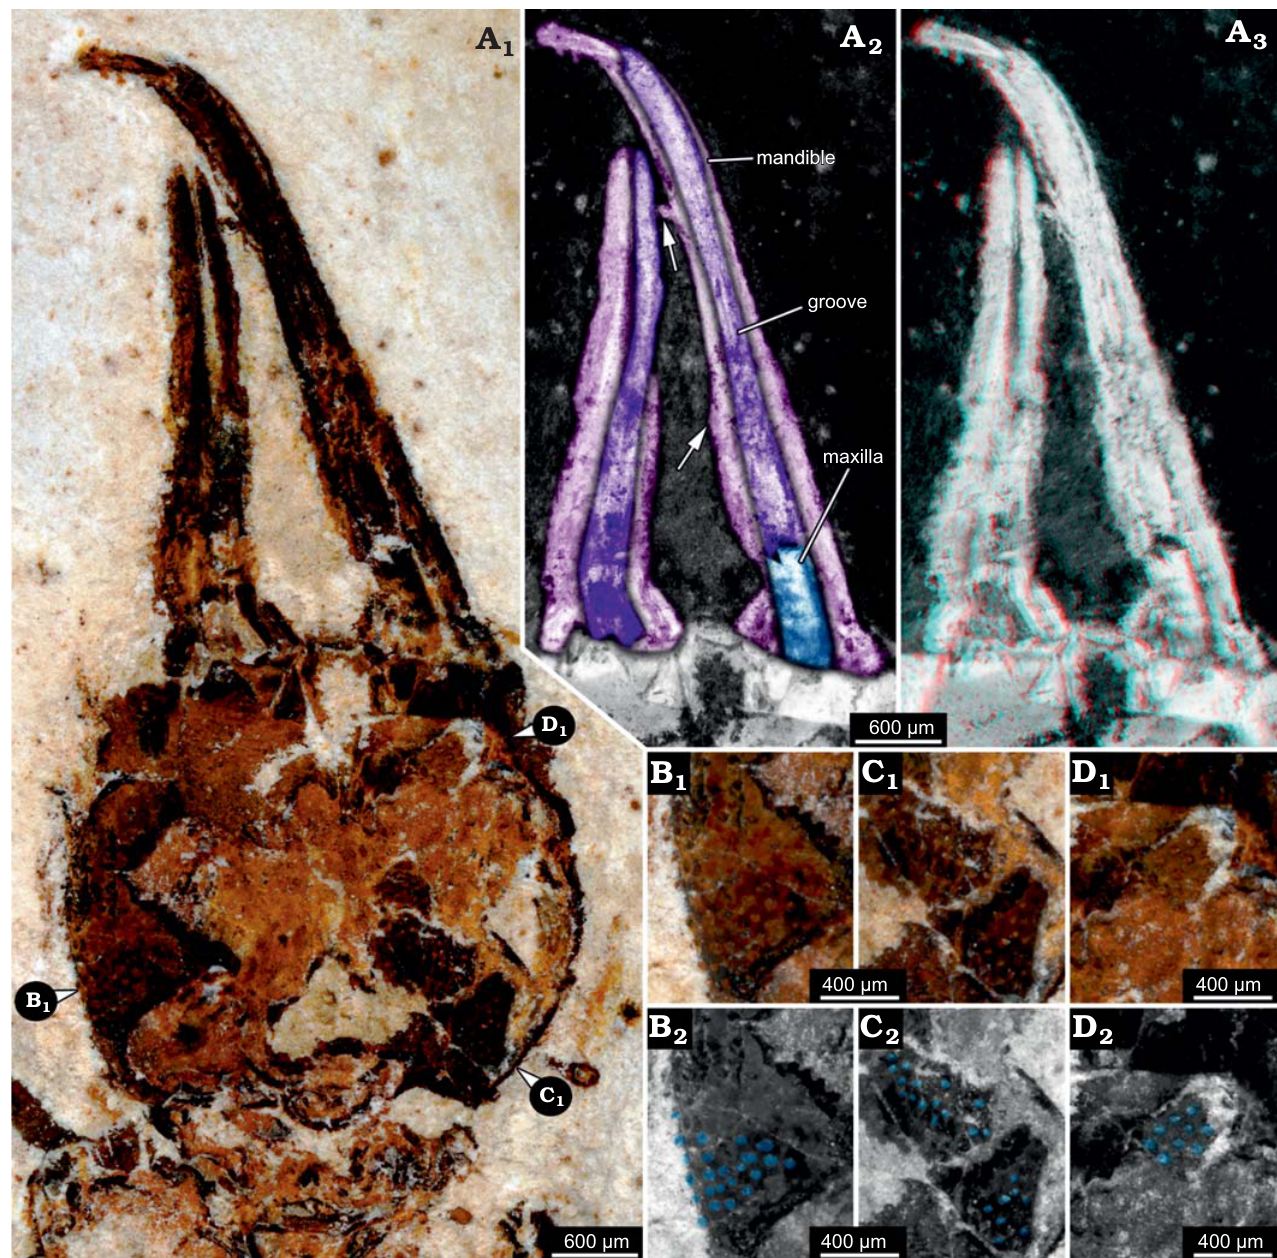
Fig. 3. Myrmeleontiformian lacewing larva (MfN MB.I 2157) from the Crato Formation, Aptian, Lower Cretaceous, Brazil. A . Head, close-up photograph in normal light (A 1 ), colour-marked details of mouth parts (A 2 ), arrows point to presumed remains of broken-off teeth, mouth parts stereo-image (A 3 ), please use red-cyan glasses to view. B – D . Different areas of head capsules with tuberculate surface, positions indicated in A 1 . Photographs in normal